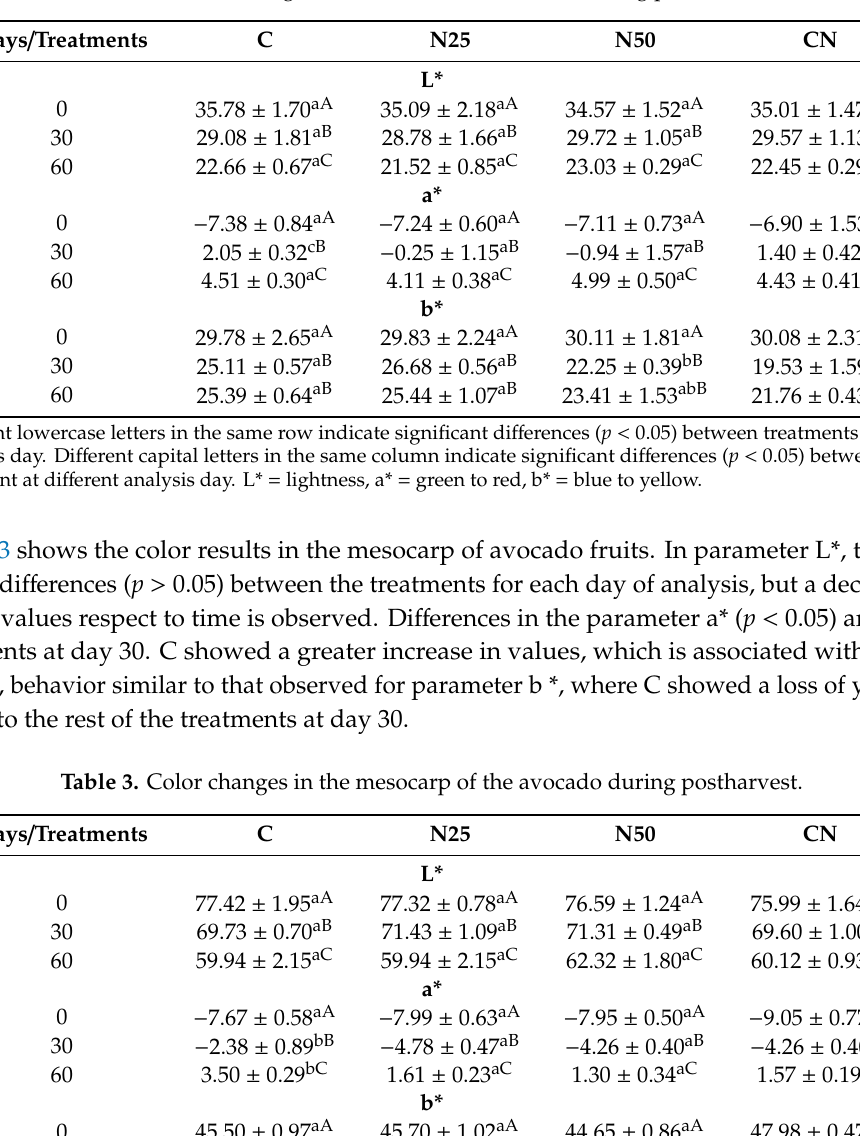
Table 2. Color changes in the skin of the avocado during postharvest.